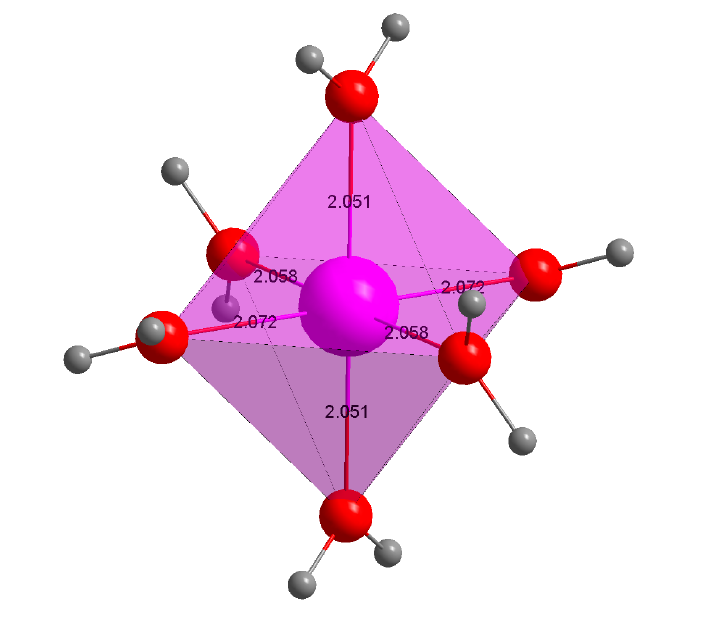
Figure 2. Octahedral environment of